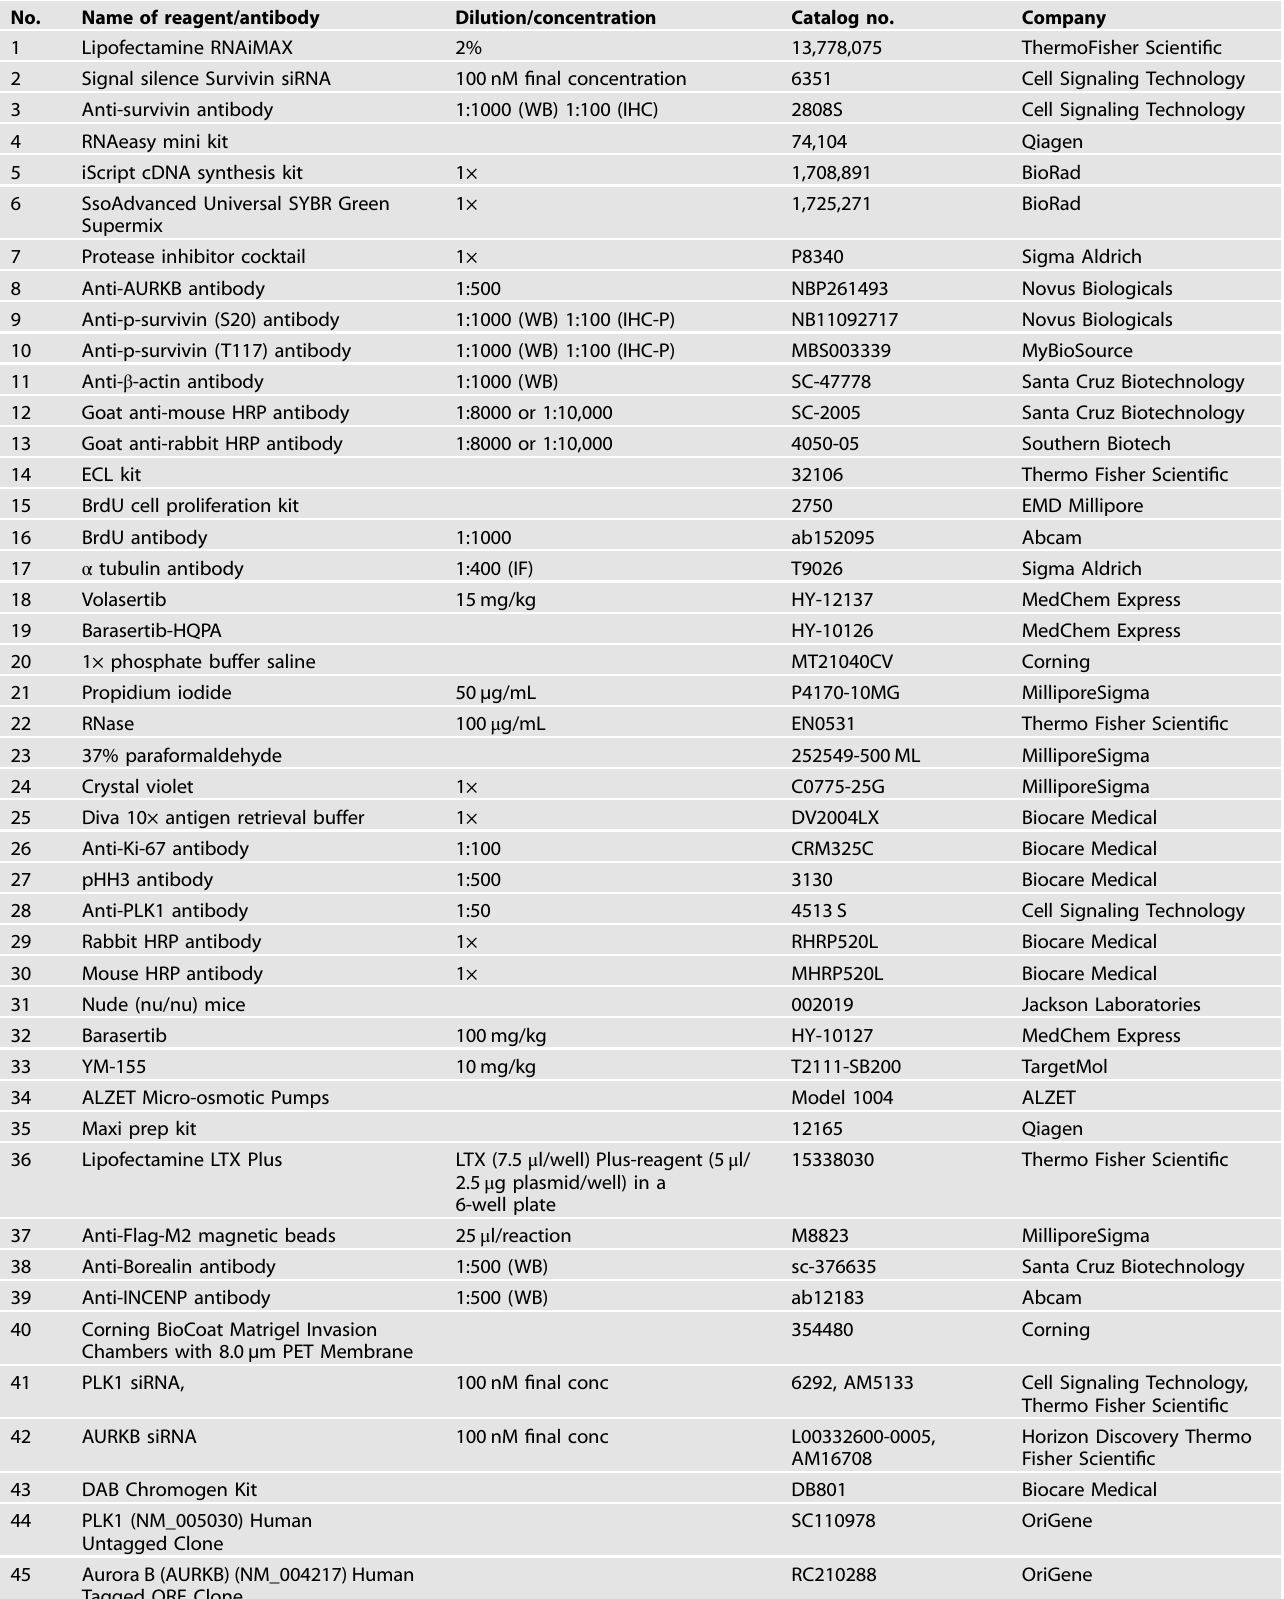
Table 1. List of reagents and